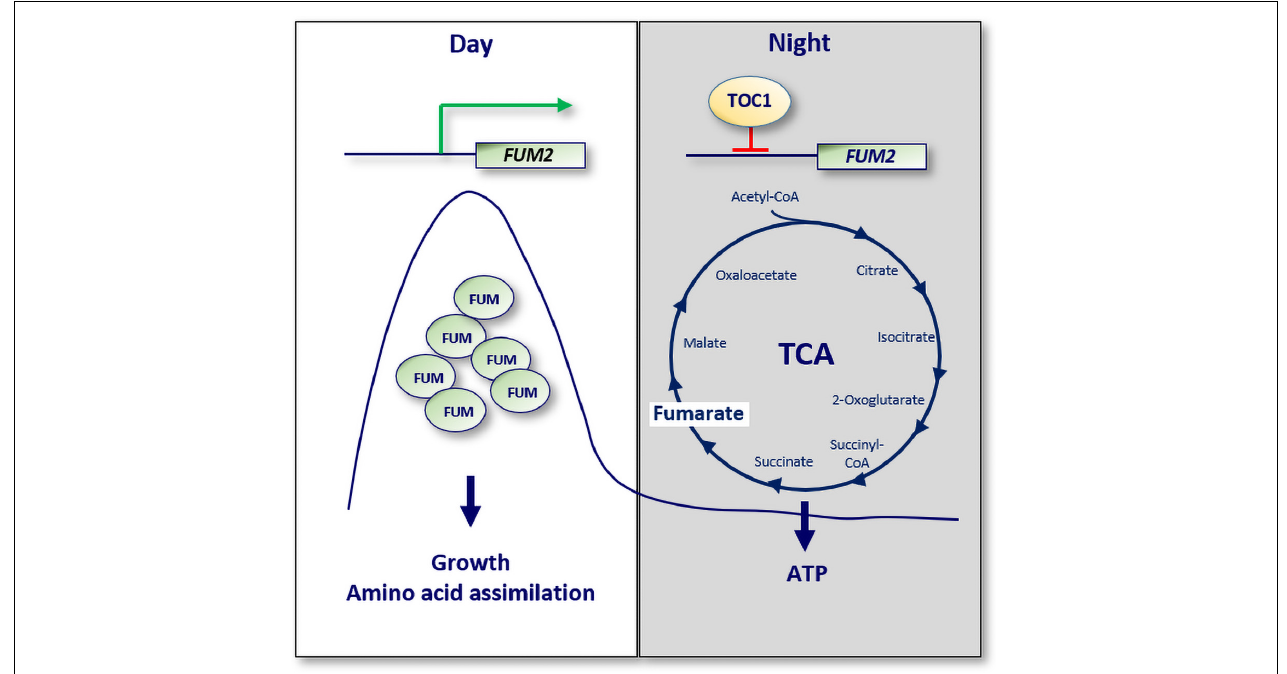
FIGURE 3 | A molecular mechanism connecting the circadian clock with cellular ATP. The expression of the TCA cycle related gene known as FUMARASE 2 (FUM2) oscillates with a peak phase during the day. Fumarate accumulation is important for growth and amino acid assimilation. TOC1 binds to the promoter of FUM2 to repress its expression at night. Consequently, the ATP/ADP ratio, a measure of energy homeostasis, is altered in TOC1 miss-expressing plants. White box: day; gray box: night; Green arrow: activation; red lines: